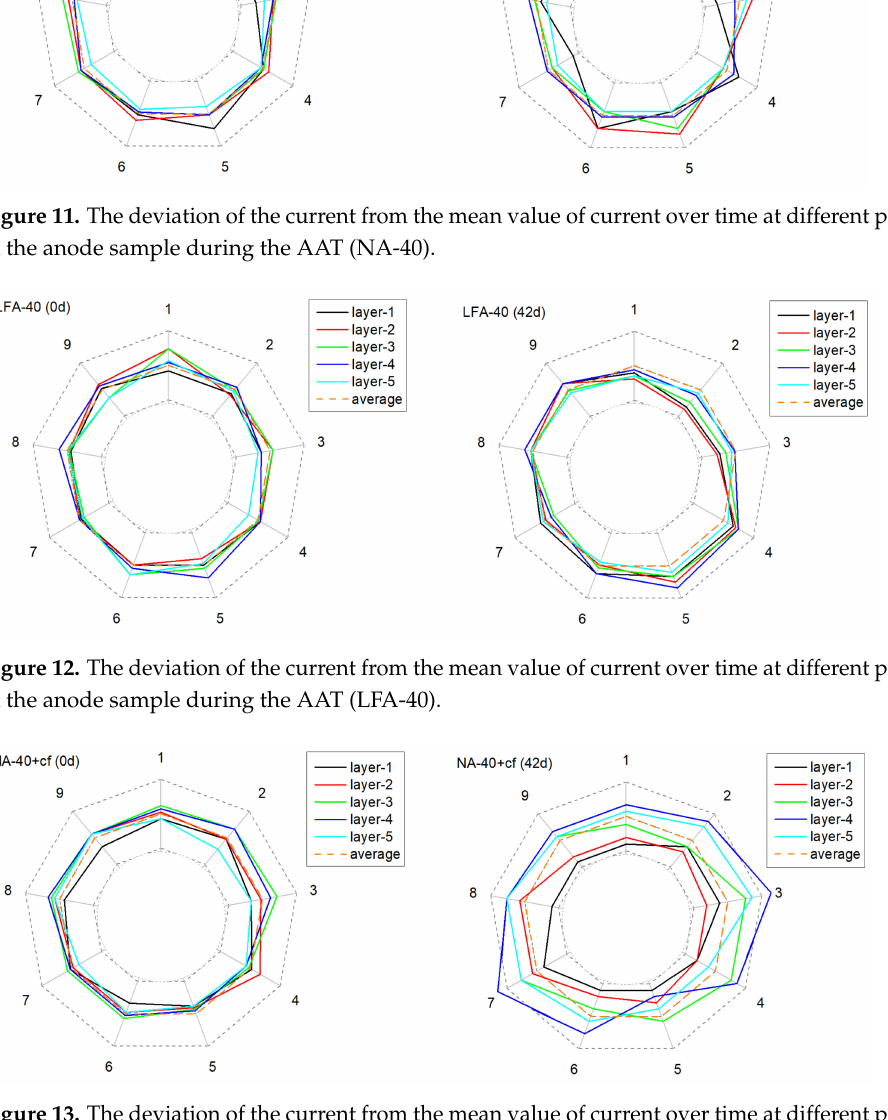
Figure 13. The deviation of the current from the mean value of current over time at different positions in the anode sample during the AAT